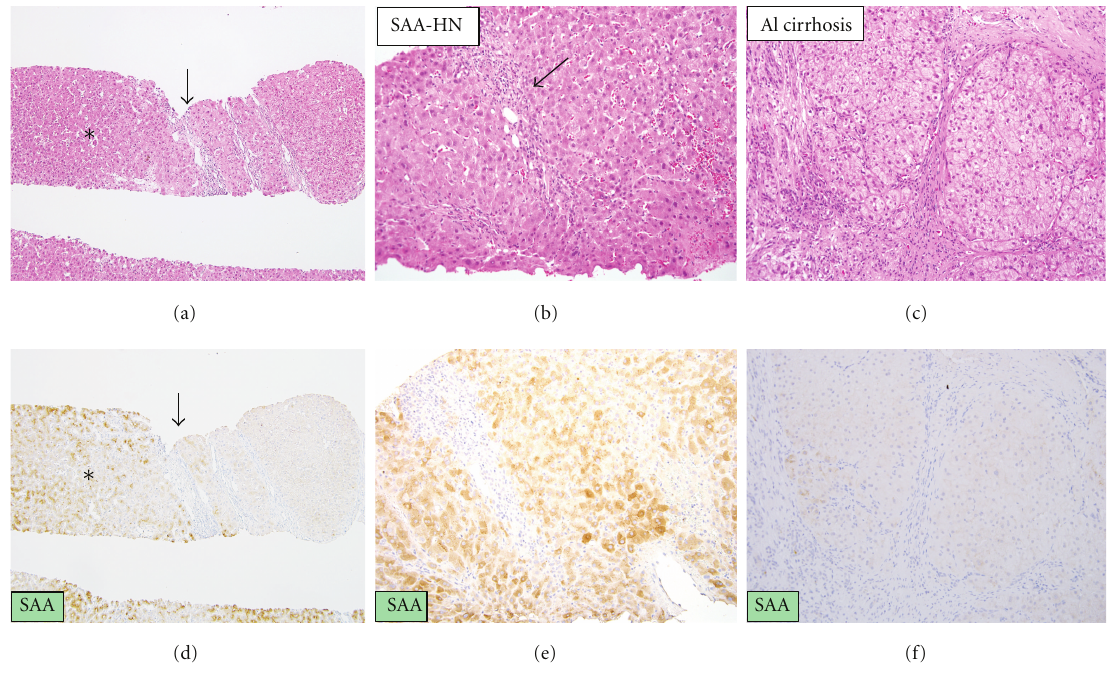
Figure 2: Serum amyloid A-positive hepatocellular neoplasm associated with alcoholic cirrhosis. (a) The boundary between serum amyloid A-positive hepatocellular neoplasm (SAA-HN) (asterisk) and nontumor tissues. Arrow indicates the boundary. × 40. (d) Serum amyloid A is expressed in the tumor, whereas it is negative in the background liver. Immunostaining for serum amyloid A, × 40. (b) Serum amyloid A-positive hepatocellular neoplasm (SAA-HN). Inflammatory cells infiltration, focal sinusoidal dilatation and ductular reaction are seen in the tumor. HE, × 200. (e) The cells in the nodule show extensive granular immunoreactivity for serum amyloid A. Immunostaining for serum amyloid A, × 200. (c) Background liver shows established micronodular cirrhosis consistent with alcoholic cirrhosis. HE, × 200. (f) The background liver shows negative immunoreactivity for serum amyloid A. Immunostaining for serum amyloid A, ×